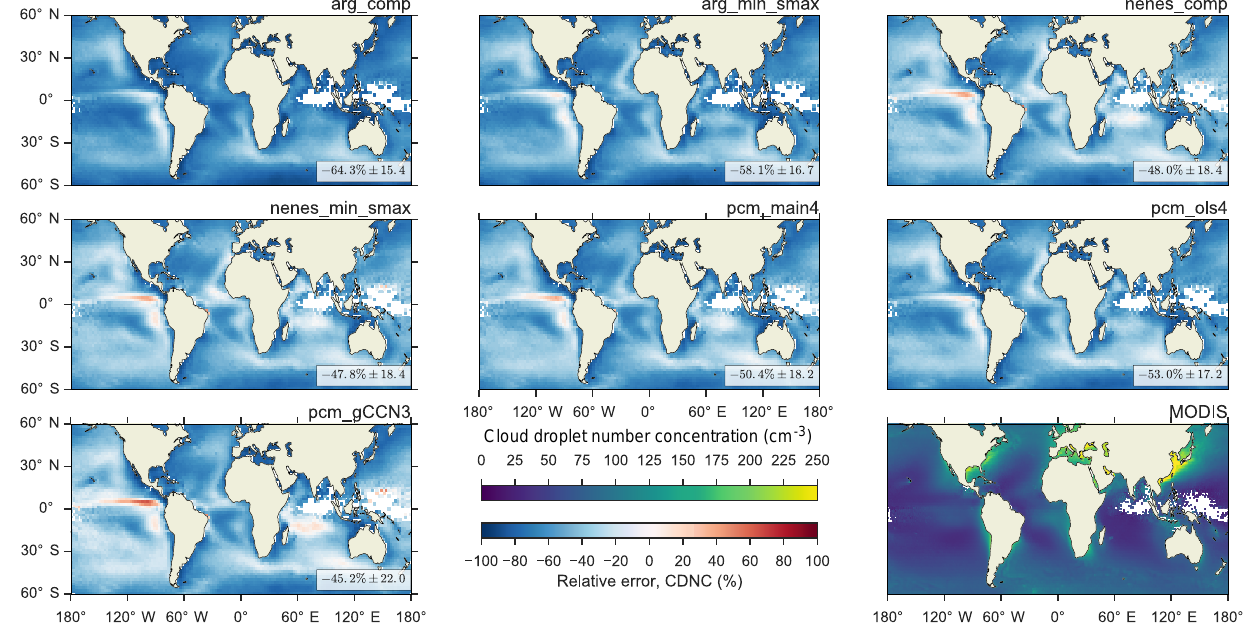
Figure 4. Global distribution in relative error of MARC-simulated CDNC versus MODIS-derived satellite observations (bottom